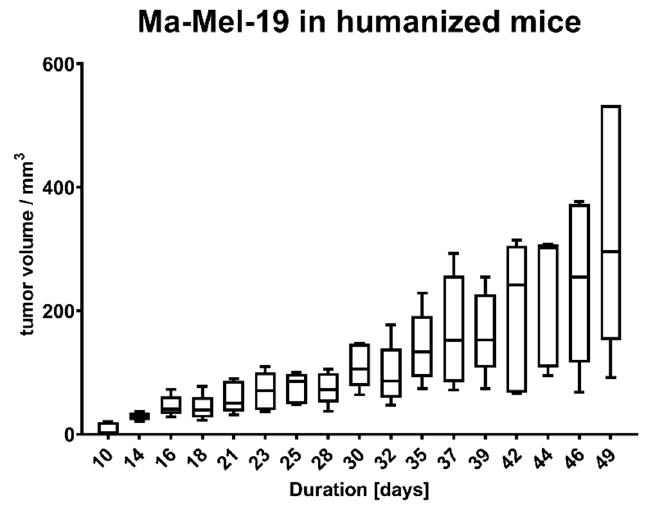
Figure 2. Tumor growth of Ma-Mel-19 cells in humanized mice. Mice were humanized on day 23. Data are shown as box plots with whiskers at min/max. six animals per group.